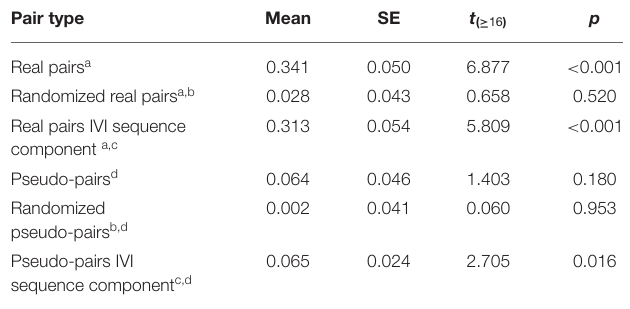
TABLE 1 | The behavioral and ecological processes contributing to the components of the alternation score when it is partitioned using a randomization or pseudo-pair analysis.